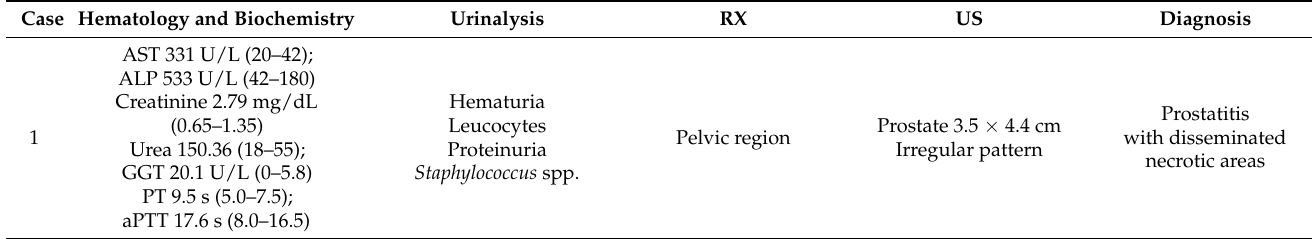
Table 2. Preoperative hematology and biochemistry tests, urinalysis results, radiographic (RX) and echographic (US) results, final diagnosis for dogs undergone perineal prostatectomy; BPH = benign prostatic